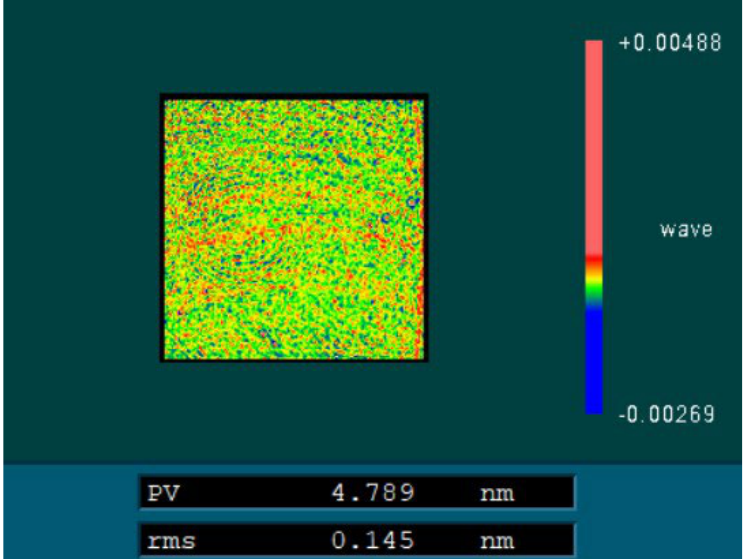
Figure 14. Surface mid-frequency band error results after uniform removal based on the magnetorheological rotation angle.